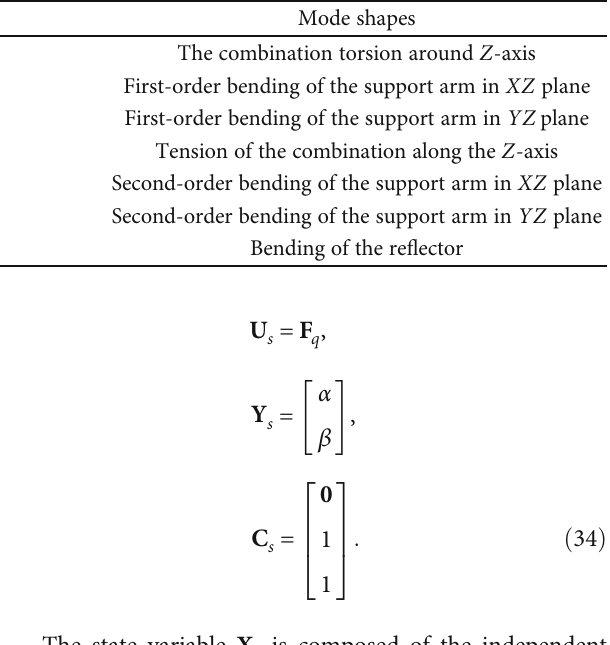
Table 1: Modal frequency and mode shape of the data transmission